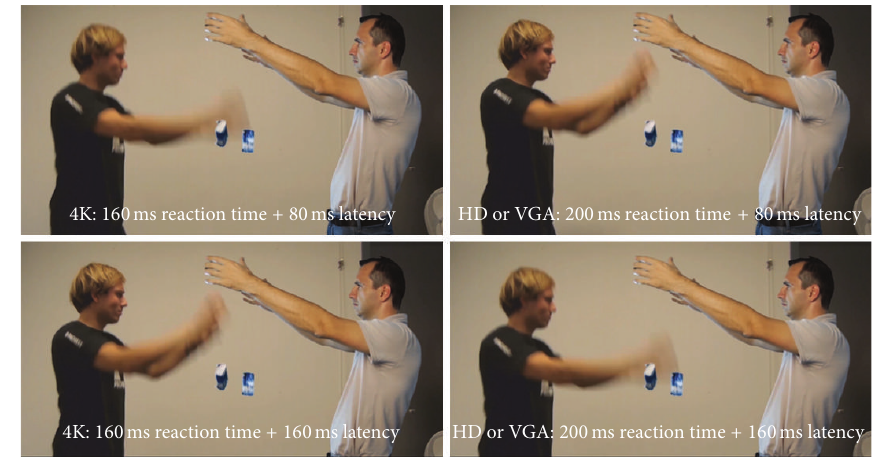
Figure 8: Snapshot of merged videos of the drop test game with average reaction time of